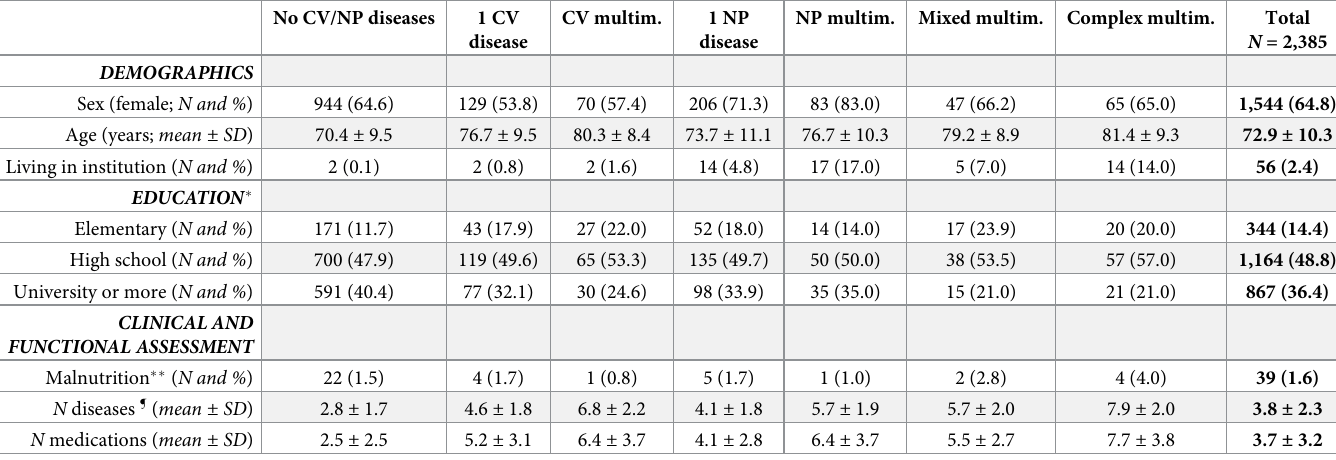
Table 1. Sample characteristics at baseline by patterns of CV and NP chronic diseases. No CV/NP diseases 1 CV CV multim. 1 NP NP multim. Mixed multim. Complex disease disease